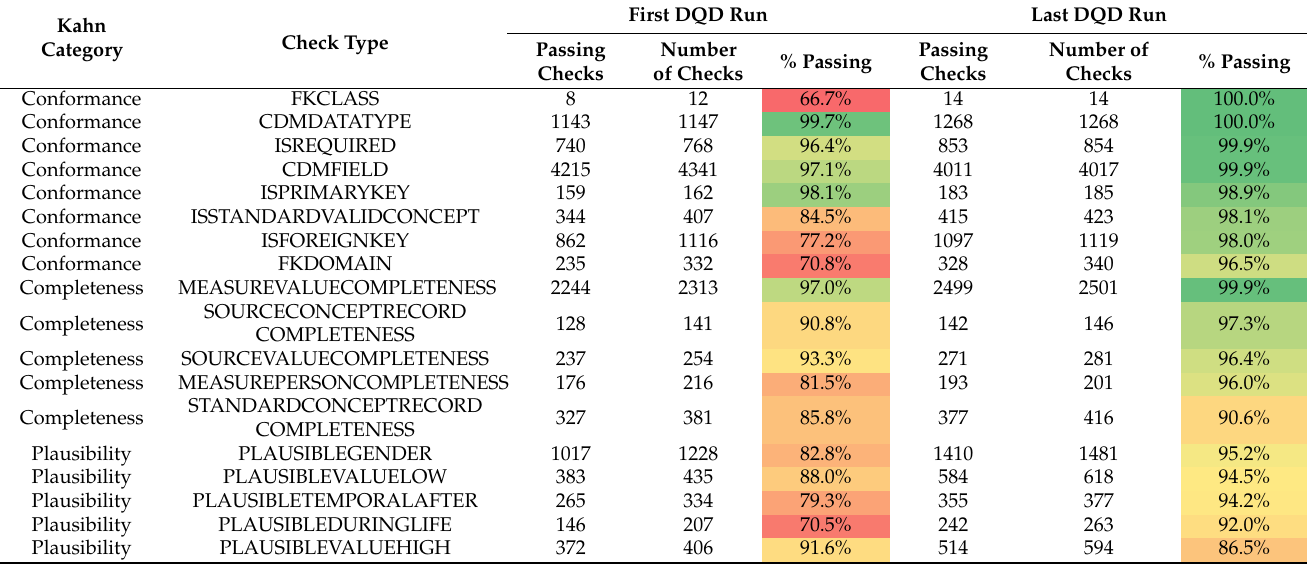
Table 3. The proportion of passing data quality checks between the first and last run of Data Quality Dashboard (DQD), for all checks run, by high-level check type and Summarized across all Data Partners